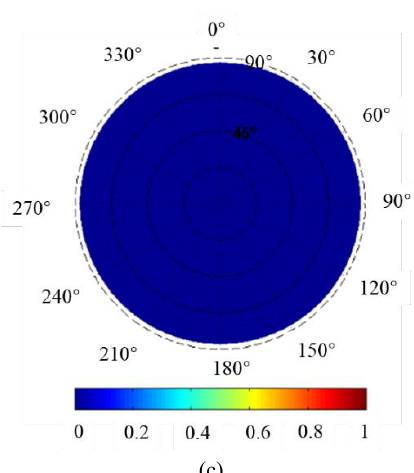
Figure 3. Measurement and the model simulation result of airlight DOP in 530nm. (a) measurement result, (b) the model